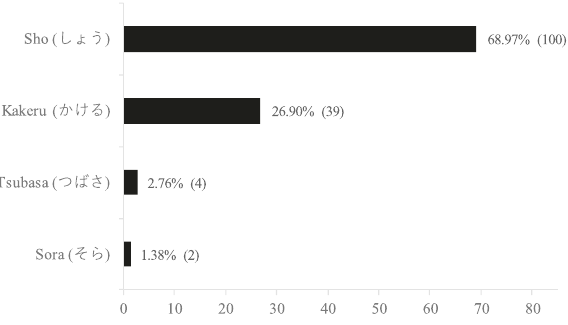
Fig. 3 Variations in readings of the name 翔 . Scores indicate relative frequencies of each reading among the sample ( n = 145). Scores in parentheses indicate the absolute frequencies of each reading.